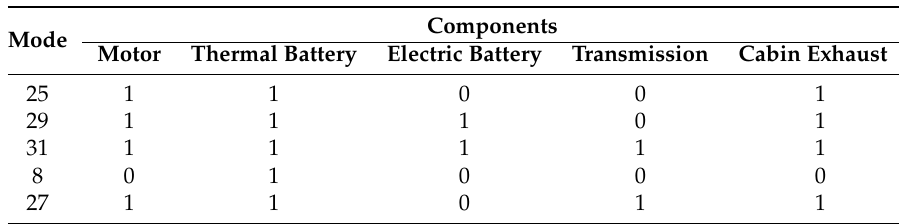
Table 2. Break down of the top 5 modes used when setting interval lengths of 5 s, 30 s, 60 s, 120 s, 300 s and 600 s, broken down into composite thermal contributors.